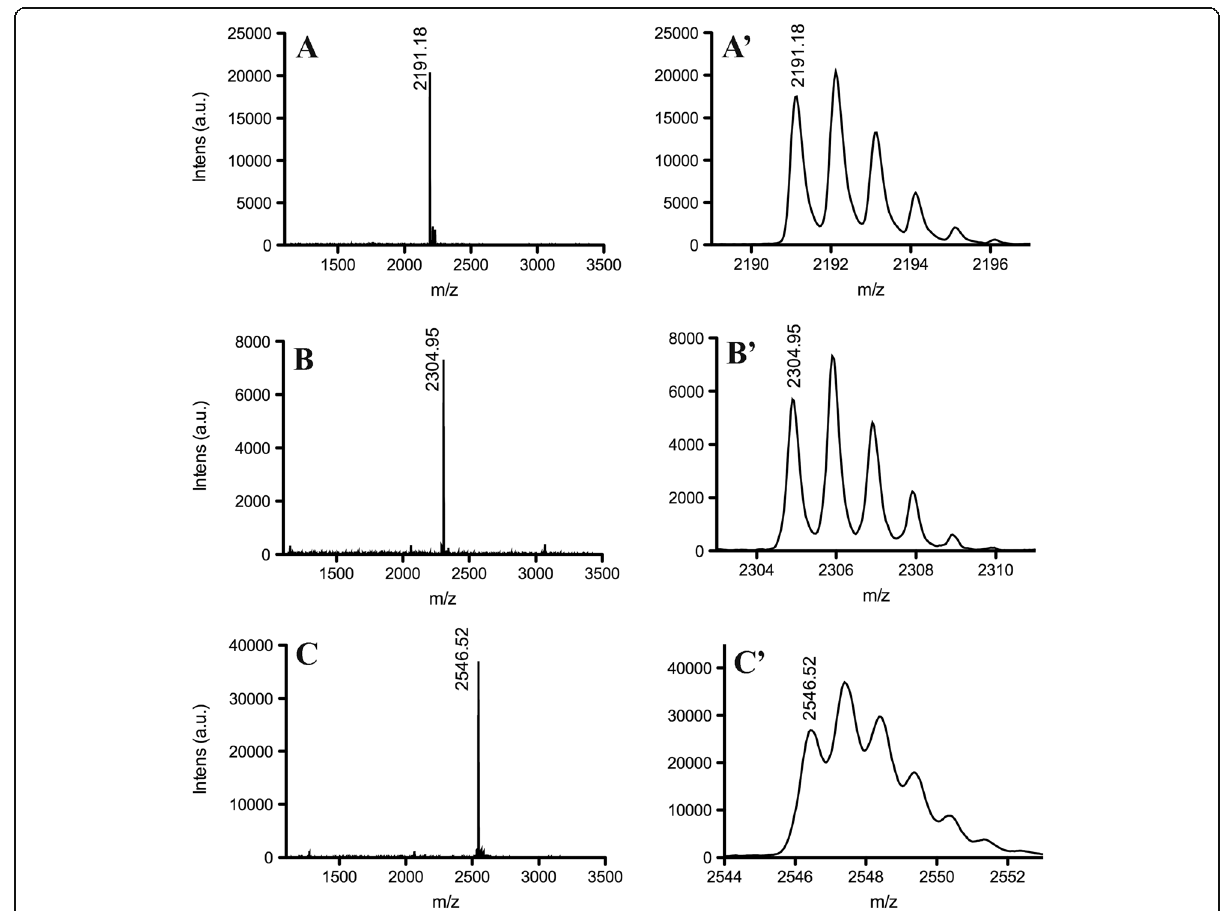
Fig. 2 Mass spectra (MALDI-TOF-MS) and expansions of the fractions corresponding to (A, A ’ ) ocellatin-LB1, (B, B ’ ) ocellatin-LB2 and (C, C ’ ) ocellatin-F1